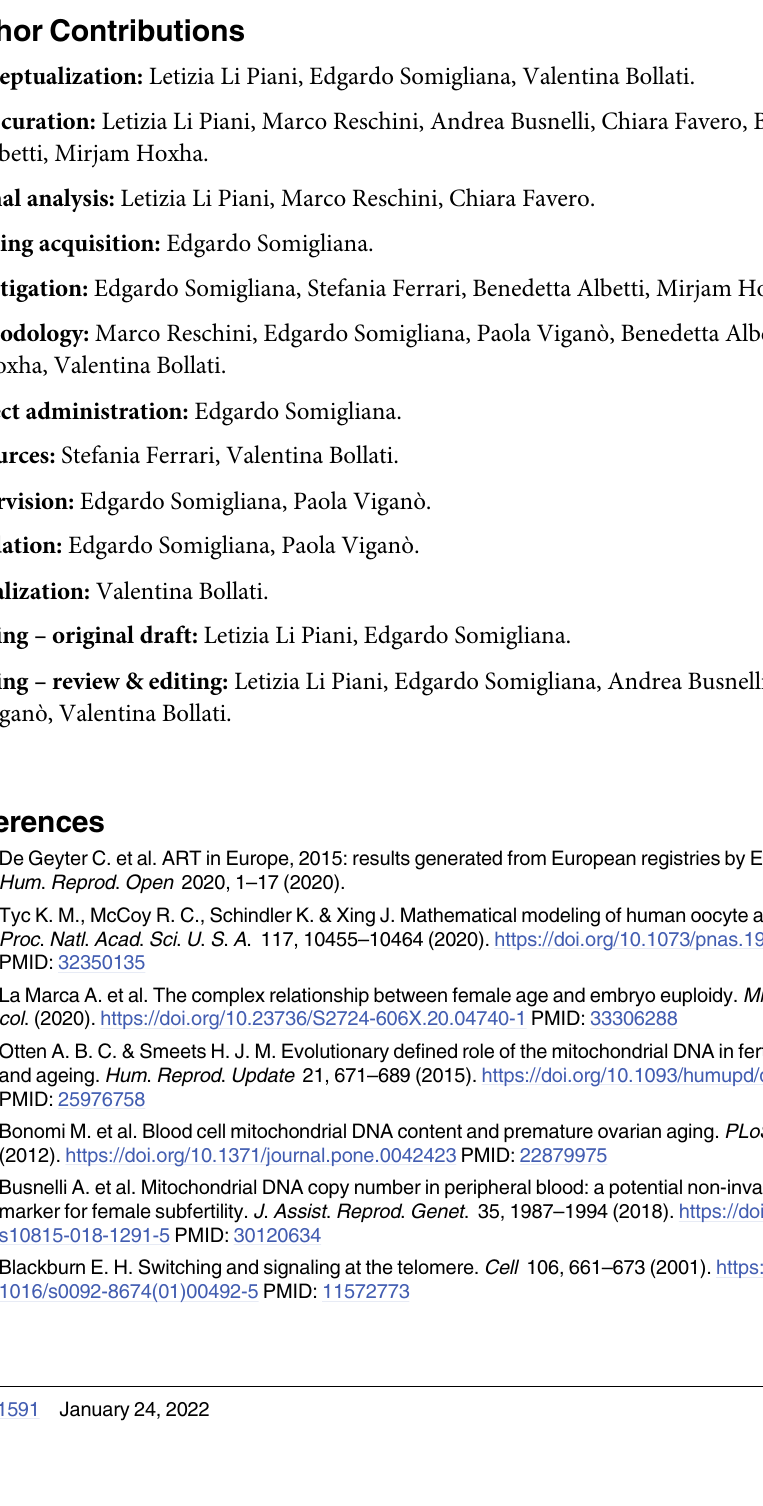
S1 Table. Biomarkers of aging in women who did and did not achieve a live birth according to the IVF